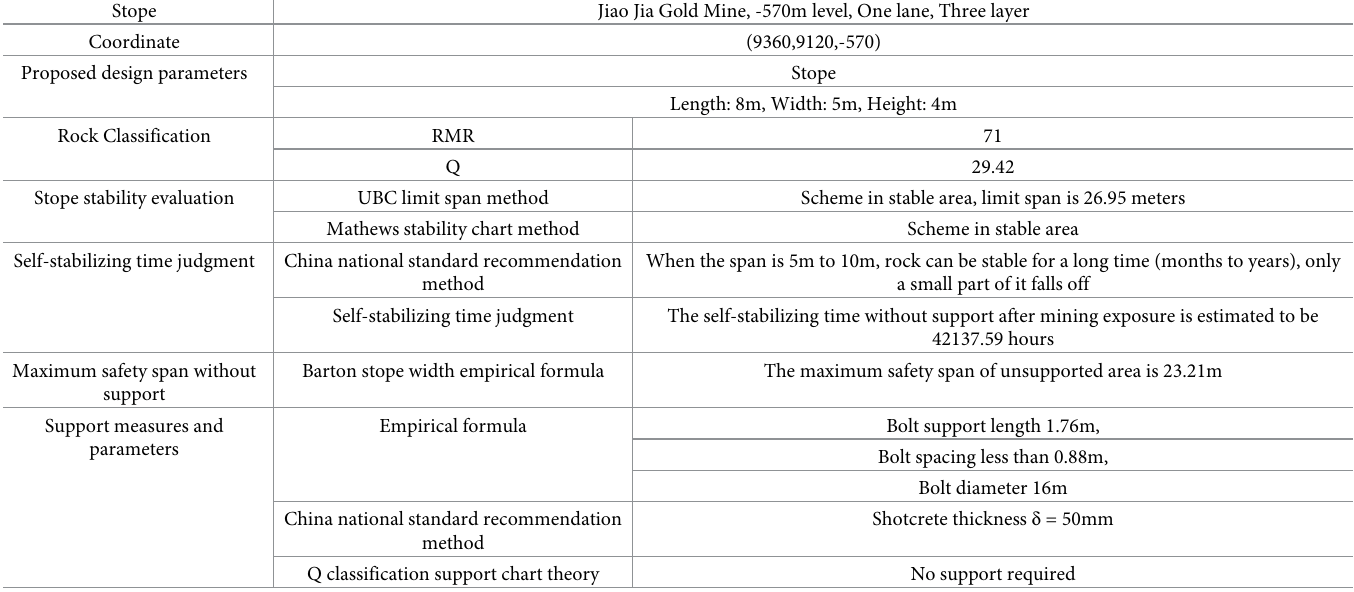
Table 6. Results of